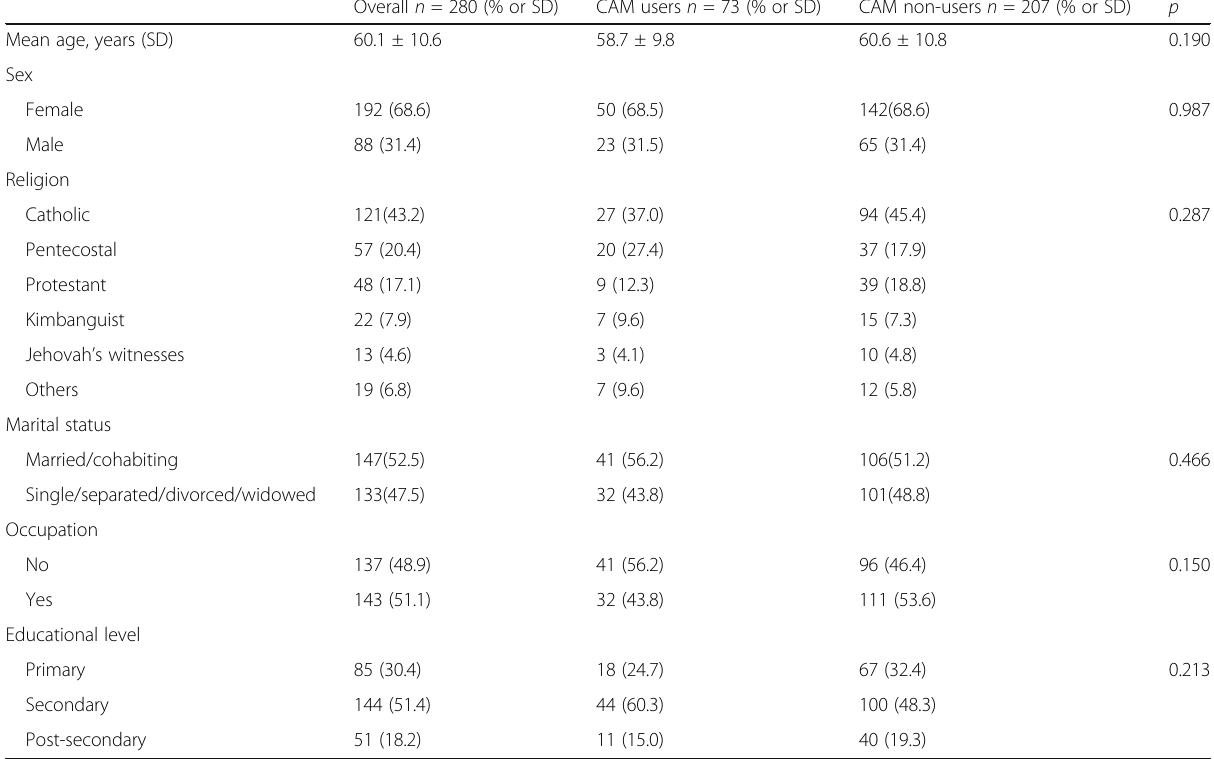
Table 4 Demographic and social characteristics of hypertensive patients using or not using